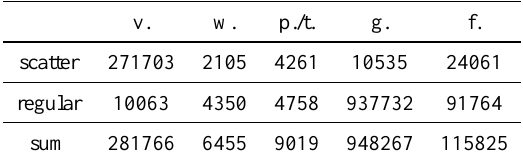
Table 1. Distribution of the classes (v.: vegetation , w.: wire , p./t.: pole/tree-trunk , g.: ground , f.: facade ) for scatter and regular region with curvature threshold 𝑐 𝑡 = 0.03